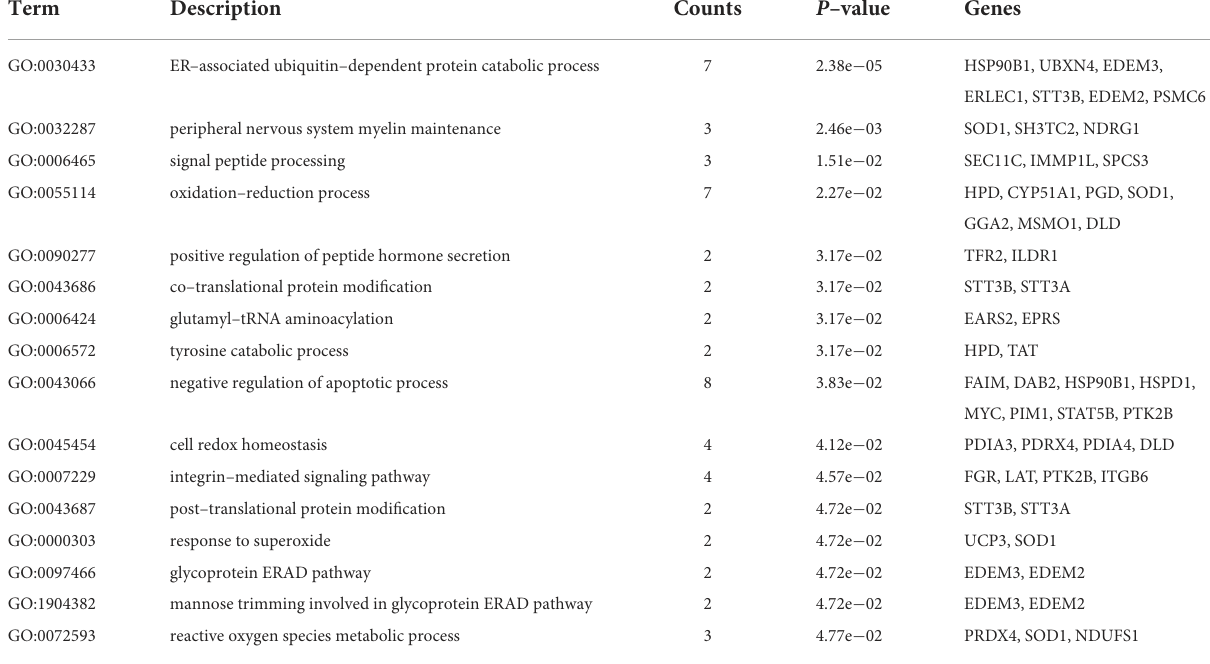
TABLE 2 Gene ontology analysis of the genes in the tan consensus module. Term